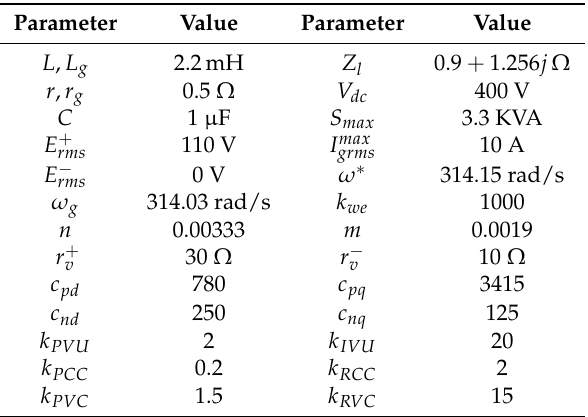
Table 1. System and controller parameters.